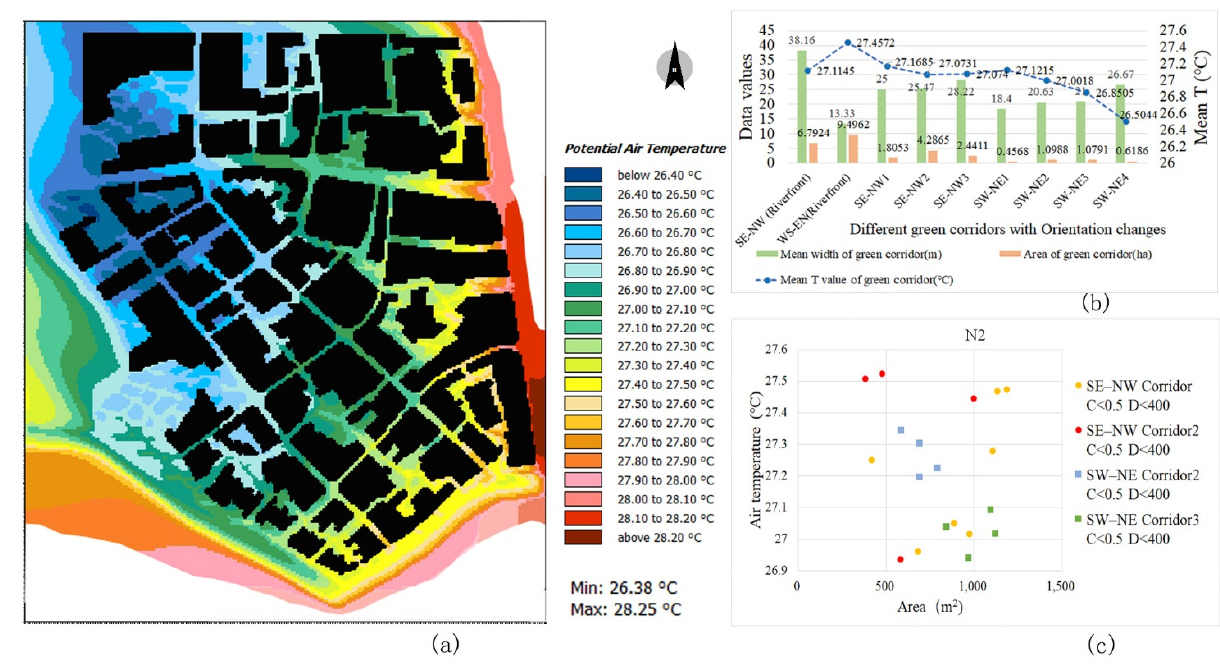
Figure 10. Ta distribution status of green corridors with different orientations at 14:00 and 1.5 m height in block N2 and comparison of the Ta difference of each green corridor segment. ( a ) Spatial distribution of Ta using ENVI-met simulation. ( b ) Comparison of mean temperatures of nine green corridors inside the block. The green corridor number is shown in Figure 2b. It can be seen that the blue-green corridors downwind of the SE–NW orientation have a significant impact on the Ta of the connected green corridors with an SW–NE orientation in the riverfront district. This blue-green spatial orientation factor affected the holistic cooling characteristics of the region such that the Ta values of the green corridors with an SW–NE orientation are mostly lower than the internal temperatures of the green corridors with an SE–NW orientation. ( c ) Comparison of Ta scatter distribution of two groups of green corridors with different orientations, the same grade of D factor and similar connection degree. It can be observed that most of the internal Ta of green corridors with an SW–NE orientation (marked by square points) are located below the internal Ta of green corridors with an SE–NW orientation (marked by circular points), which are relatively low.